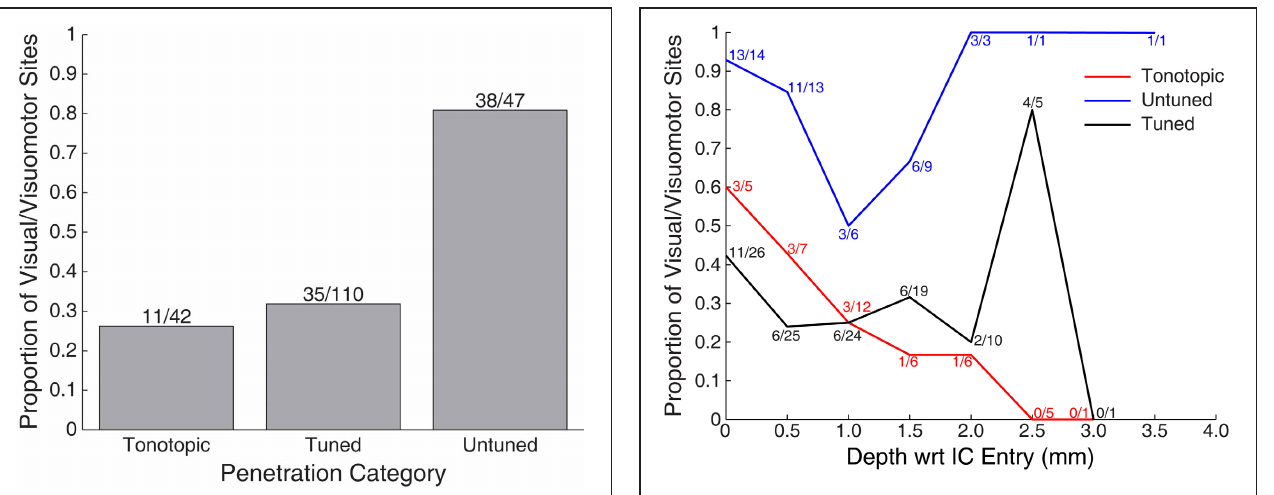
FIGURE 4 | Proportionof visually responsive recordings in tonotopic, tuned, and untuned recording penetrations. The height of bars indicates the proportion of sites showing visual sensitivity in each auditory class of recording penetration. Untuned penetrations contained the largest proportion of sites, tuned, and tonotopic penetrations contained far fewer.